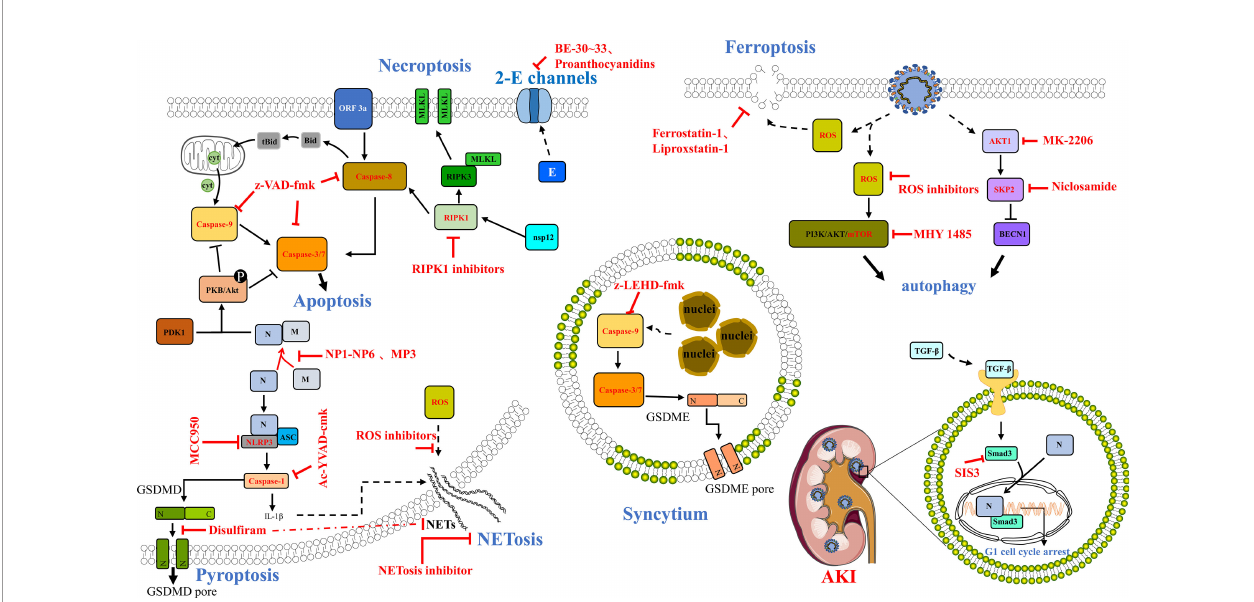
FIGURE 2 | Potential compounds or drugs that targeted different cell death pathways. The potential therapeutics of drugs or compounds to inhibit cell death, including the use of z-VAD-fmk, a pan-caspase inhibitor, to reduce the caspase activity and block the apoptosis induced by SARS-CoV-2 ORF3a, and the use of RIPK1 inhibitors (Nec-1s, GSK ′ 481/GSK ′ 772, etc.), as well as using peptides such as NP1-NP6 and MP3 to disrupt the M – N interaction, and abolish the activity of N on the M-triggered apoptosis. In addition, a speci fi c inhibitor of NLRP3 called MCC950 and an inhibitor of caspase-1 named Ac-YVAD-cmk can block NLRP3 in fl ammasome